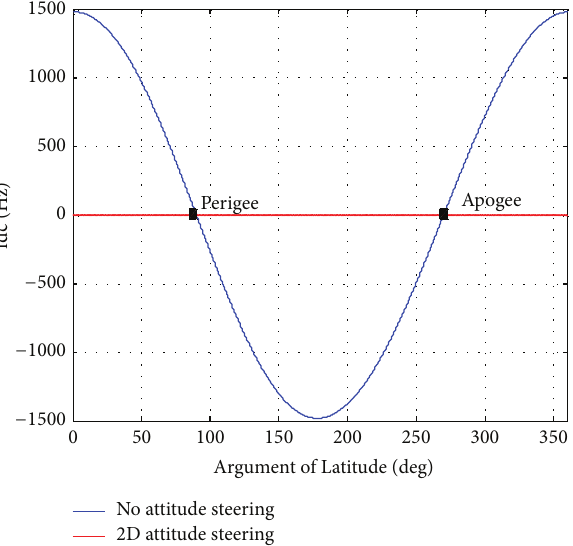
Figure 3: Comparison of the Doppler residuals before and after the attitude